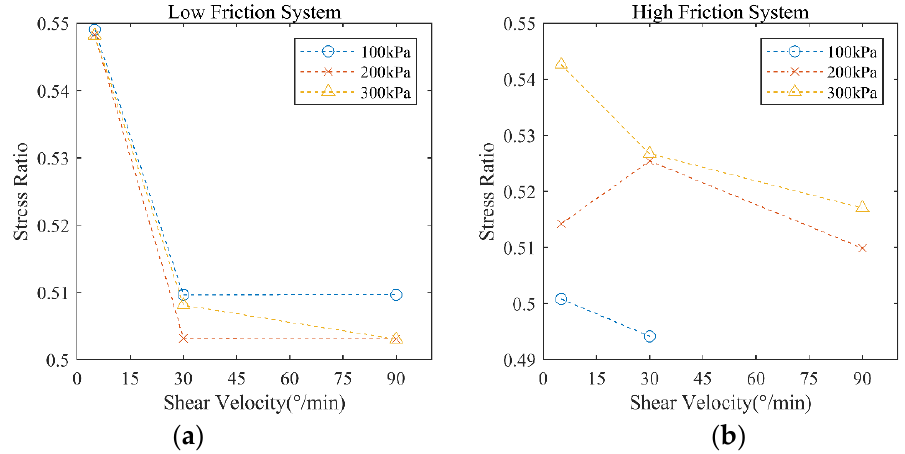
Figure 5. Relationship between shear velocity and stress ratio under different normal stresses. ( a )